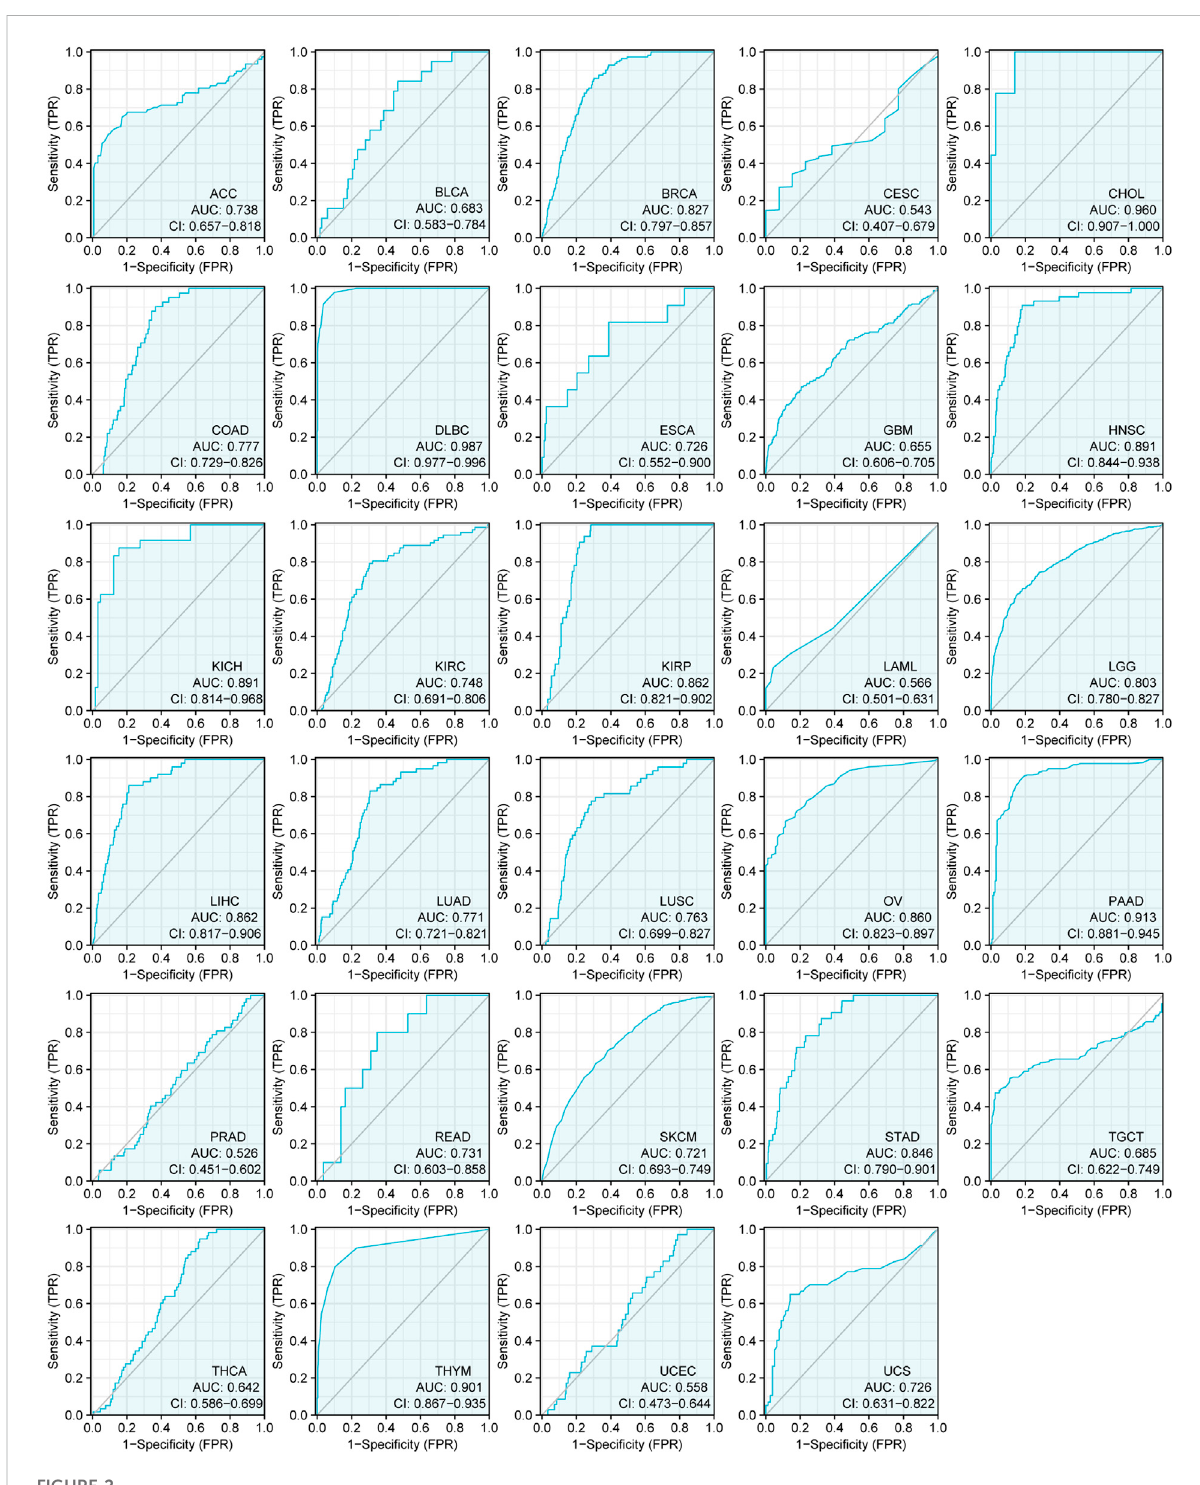
FIGURE 2 The ROC curves of CSMD2 expression as a diagnostic biomarker in tumor and normal tissues. AUC, area under